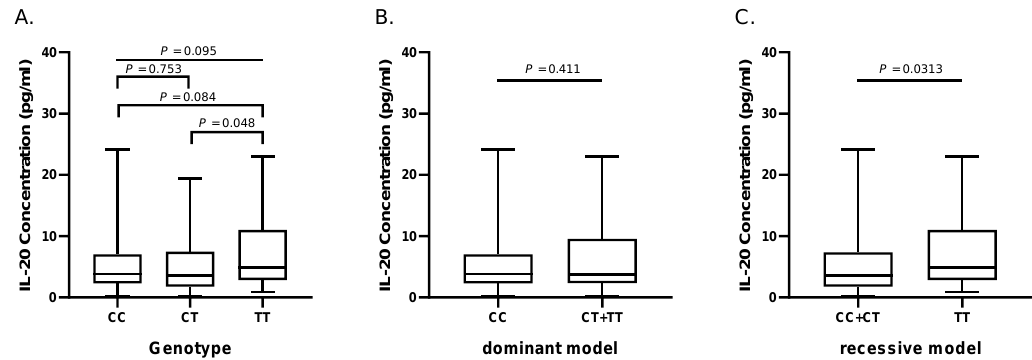
Figure 1. Association of the rs1400986 genotypes with IL-20 concentrations in control individuals. ( A ) Individuals with TT genotype have significantly higher IL-20 concentrations that those individuals with CT genotype (4.9 (3.1–10.7) pg / m vs. 3.8 (1.8–7.1) pg / mL, respectively, P = 0.048). ( B ) IL-20 concentrations in individuals with CC vs CT + TT genotypes (dominant model). No di ff erences were observed. ( C ) IL-20 concentrations in individuals with CC + CT vs. TT genotypes (recessive model). Individuals with TT genotype have significantly higher IL-20 concentrations that those individuals with CC + CT genotype (4.9 (3.1–10.7) pg / m vs. 3.6 (1.8–7.1) pg / mL, respectively, P = 0.0313). Lines into bars indicate median; interquartile range (IQR 25–75) is shown in graphic representation. P : Kruskal-Wallis test and Mann-Whitney U-